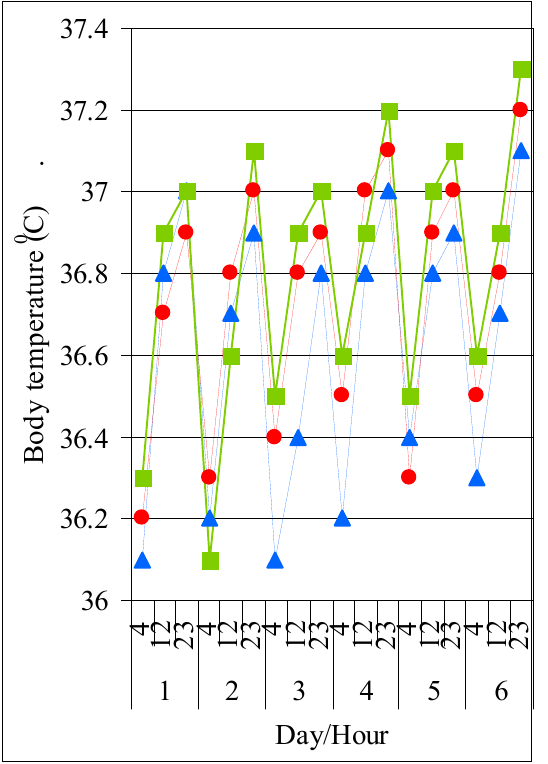
Figure 10. Body temperature variation at different times of the day (hour 4:00, 12:00 and 23:00) ( ▲ )—Coxswain; ( ● )—Mechanic and ( ■ )—Sailor.